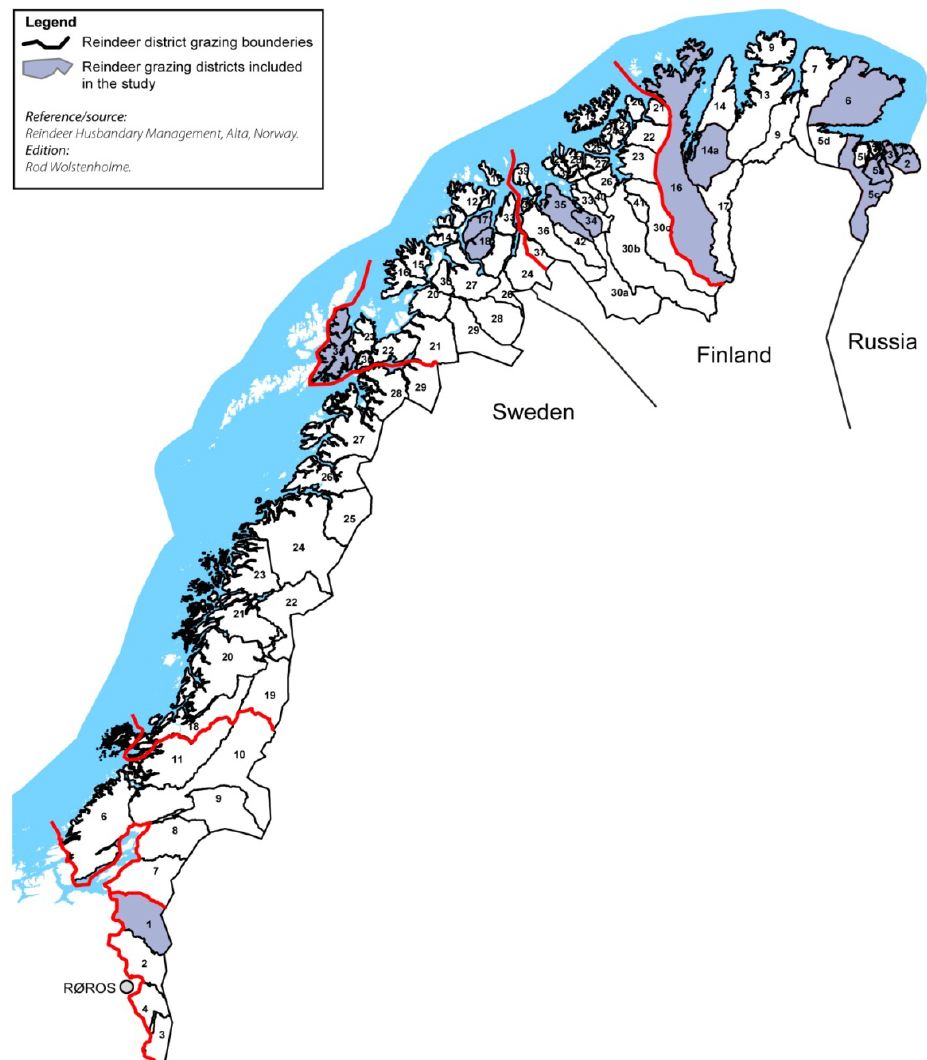
Figure 1. Map of the study